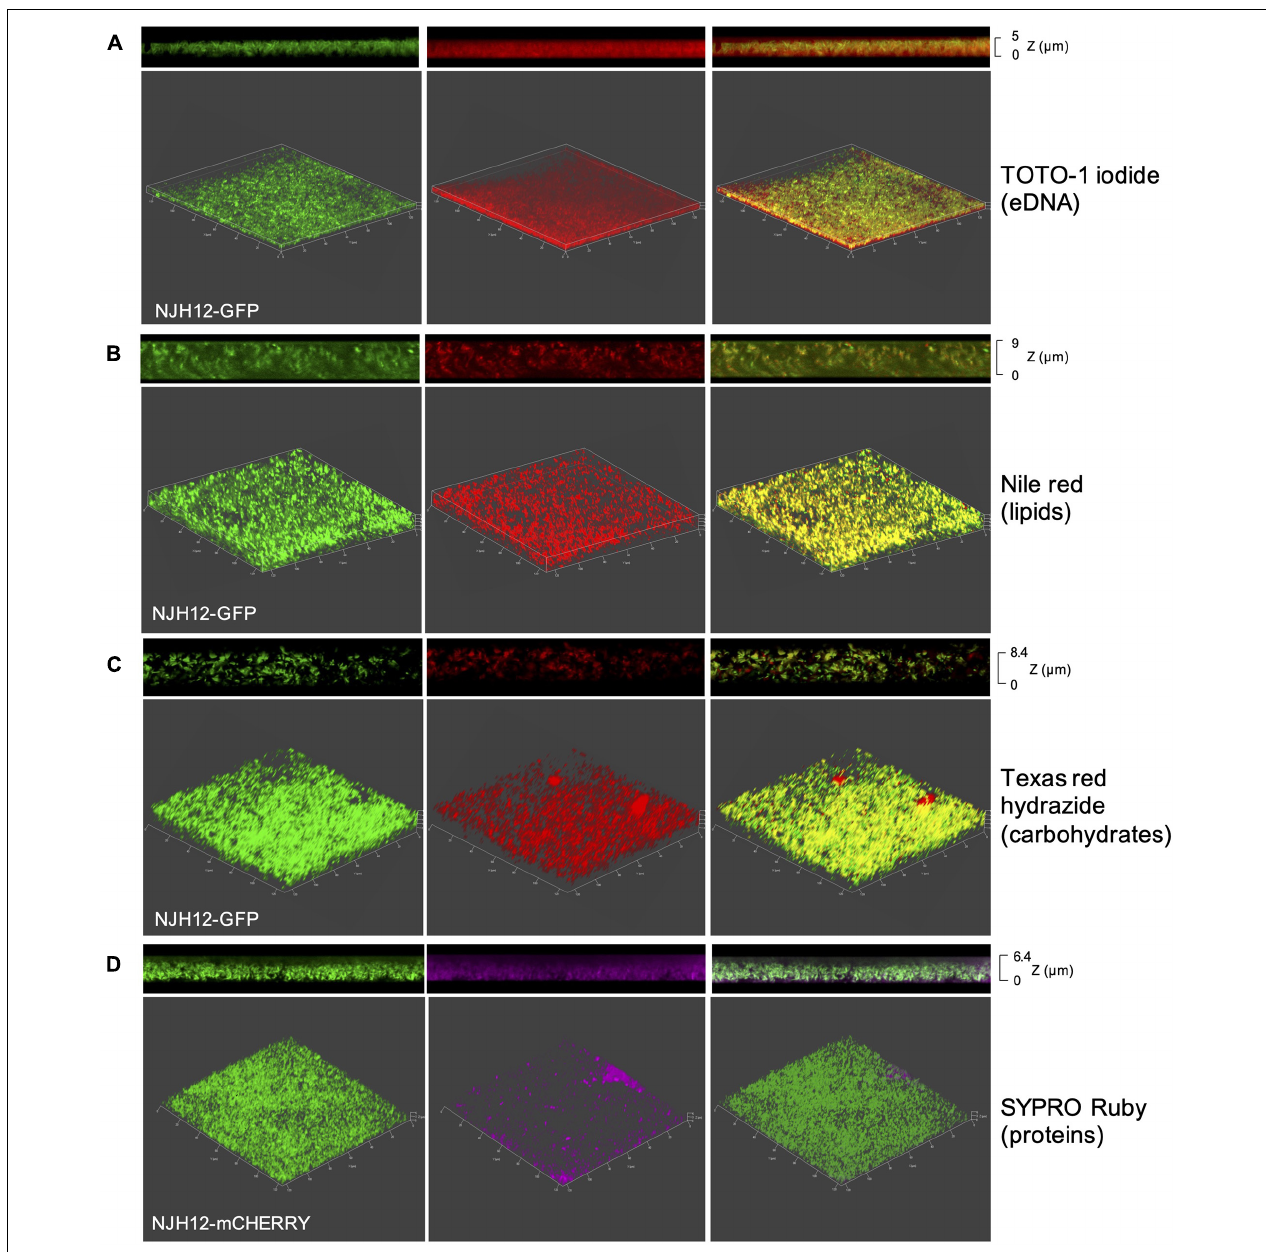
FIGURE 2 | Staining of MABSC biofilms with protein, lipid, polysaccharide, and DNA-specific dyes. mCherry- or GFP-expressing Mabs NJH12 biofilms were stained with TOTO-1 iodide for staining eDNA (A) , Nile red for staining intra- and extra-cellular lipids (B) , Texas Red hydrazide for staining extracellular polysaccharides (C) and SYPRO Ruby for staining extracellular proteins (D) . Shown are three-dimensional (bottom; X × Y × Z = 128 µ m × 128 µ m × 5–9 µ m) and side views (top) of the stained biofilms as analyzed by fluorescence confocal imaging. Left panel: mCherry- or GFP-expressing Mabs NJH12. Middle panel: constituent-specific staining of the biofilm; Right panel: overlay of the previous